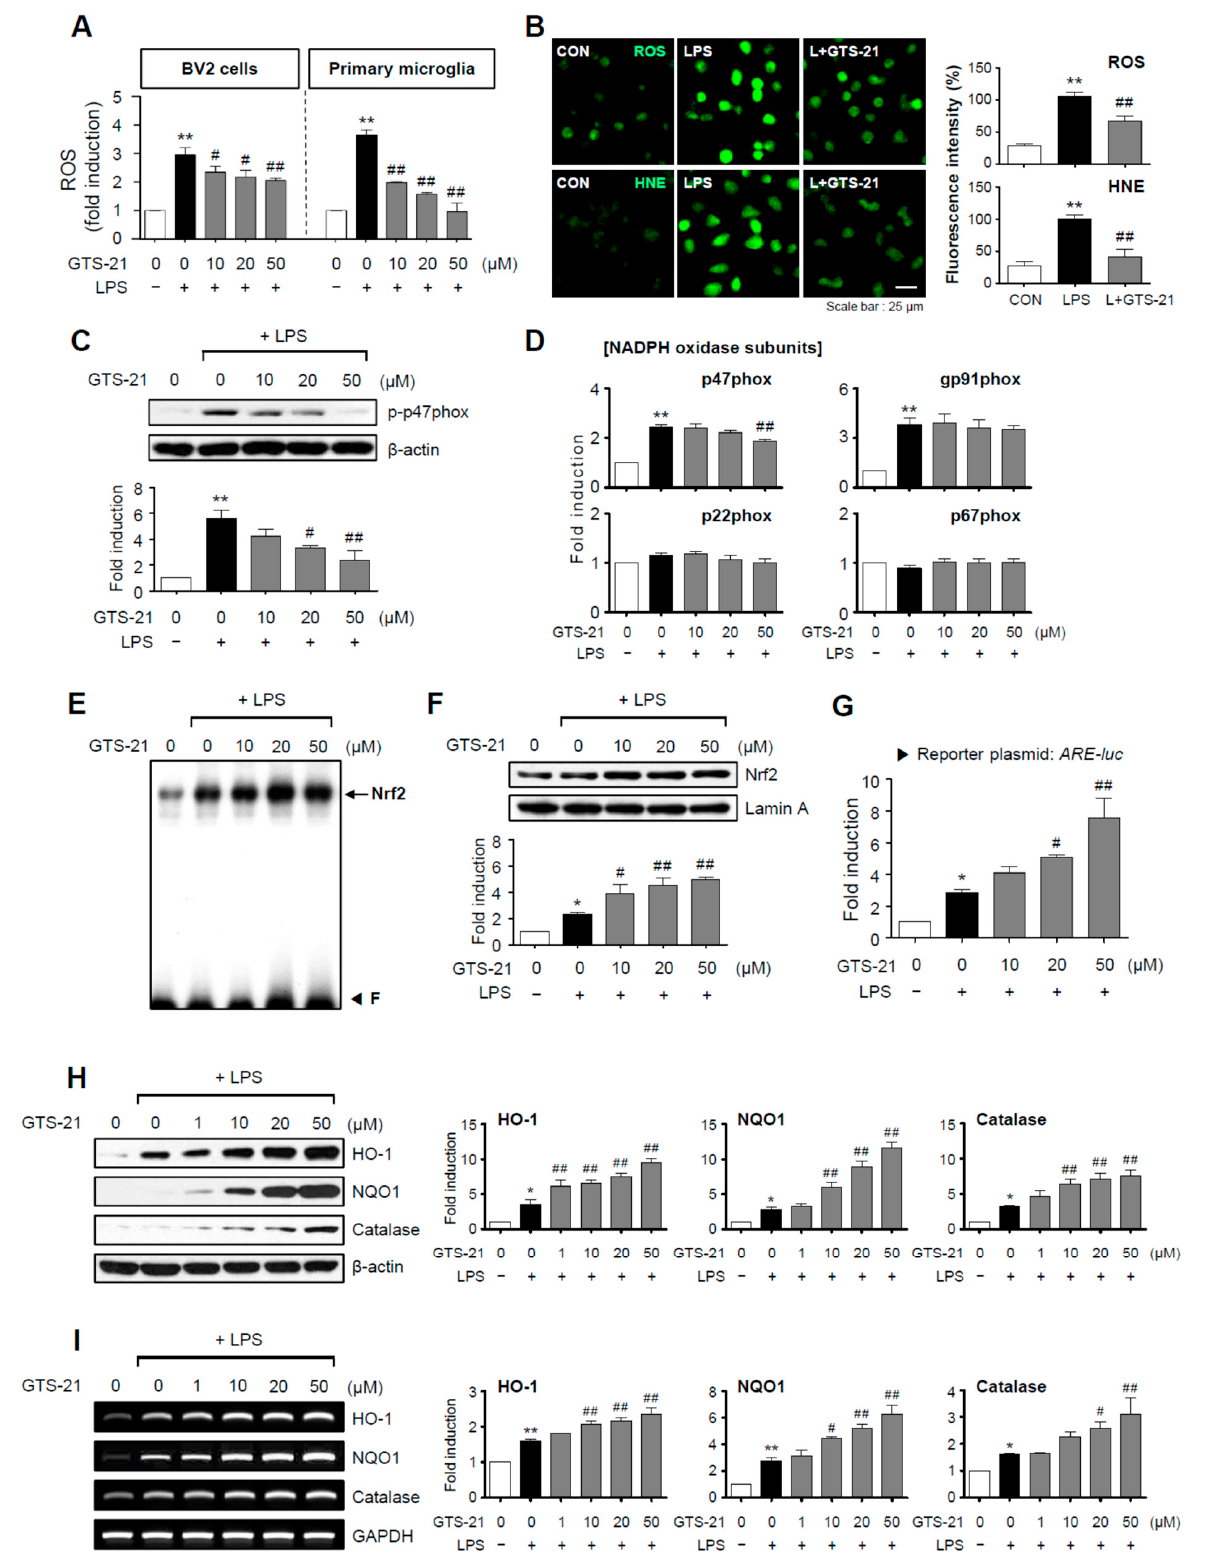
Figure 3. GTS-21 inhibited the production of ROS and HNE by inhibiting the NADPH oxidase subunit p47phox and increasing Nrf2/ARE signaling. ( A ) GTS-21 was applied to microglial cells 1 h before LPS stimulation for 16 h, and intracellular ROS levels were measured using the DCF-DA method ( n = 4). ( B ) A representative confocal image of CellROX-derived fluorescence generated by intracellular ROS, and immunofluorescence staining for HNE in BV2 cells ( n = 4). ( C ) Phosphory- lation of the p47phox subunit was determined using western blot analysis ( n = 3). ( D ) Quantitative